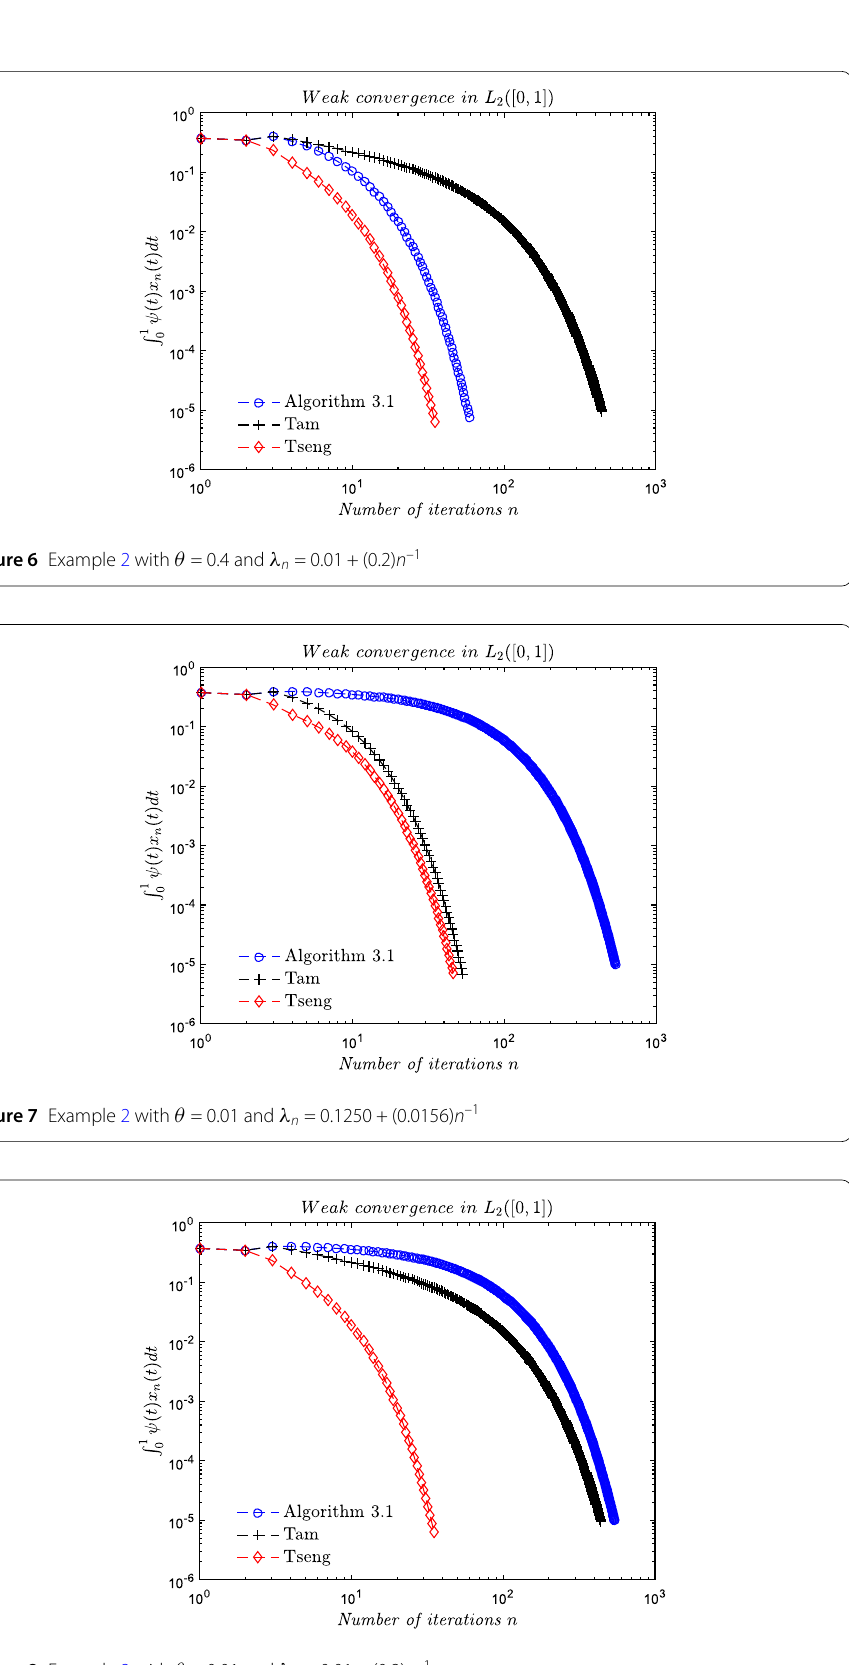
Figure 8 Example 2 with θ = 0.01 and λ n = 0.01 + (0.2) n